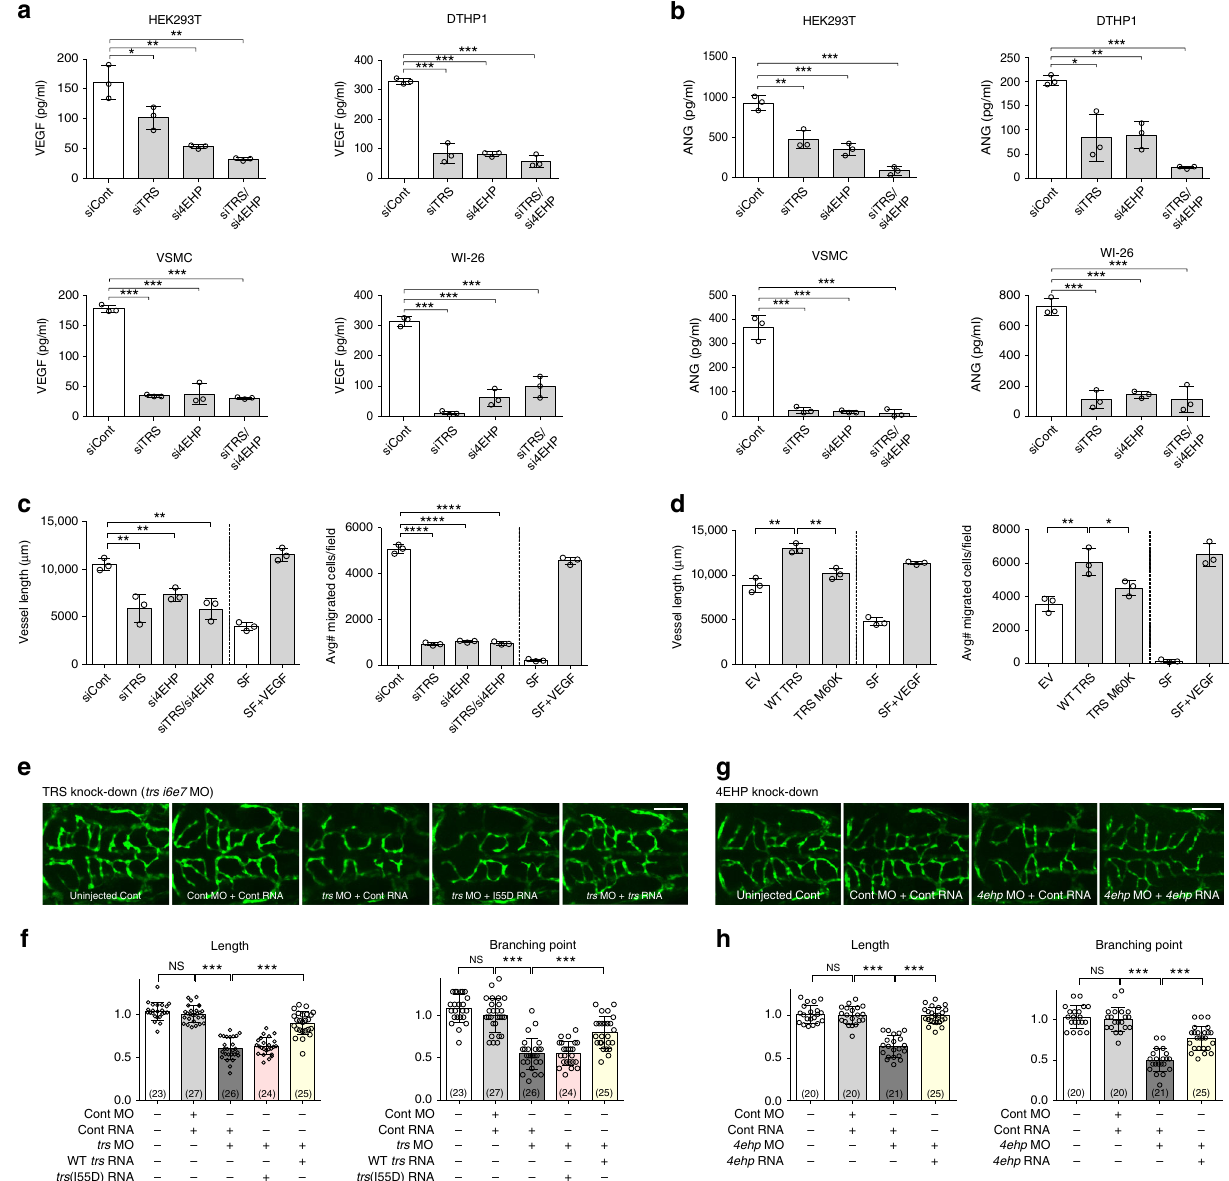
Fig. 5 The 4EHP and TRS interaction is critical for translation initiation of mRNAs required for vascular development. a Effects of TRS and/or 4EHP on VEGF secretion in siTRS- and/or si4EHP-transfected cell lines. VEGF protein levels in the culture supernatant were determined by enzyme-linked immunosorbent assay (ELISA). b Effects of TRS and/or 4EHP on ANG secretion in siTRS- and/or si4EHP-transfected cell lines. ANG protein levels in the culture supernatant were determined by ELISA. c , d Effects of TRS and/or 4EHP on endothelial cell tube formation. Culture medium from WI-26 cells transiently transfected with siRNAs against TRS and/or 4EHP (or siCont) was used to treat HUVECs, which were subsequently plated on growth factor- reduced Matrigel to form capillary tubes ( c ). Total tube lengths in Supplementary Fig. 6a were measured using ImageJ ( c ). Migrated HUVECs were counted from three randomly selected fi elds ( c ). Culture medium from WI-26 cells transiently transfected with Myc-TRS WT or its 4EHP-binding-defective M60K mutant was used to treat HUVECs, which were subsequently plated on growth factor-reduced Matrigel to form capillary tubes ( d ). Total tube lengths in Supplementary Fig. 6f were measured using ImageJ ( d ). Migrated HUVECs were counted from three randomly selected fi elds ( d ). VEGF (10 ng mL -1 ) served as a positive control. siCont, non-targeting control siRNA. * p < 0.05; ** p < 0.01; *** p < 0.001; **** p < 0.0001 vs. control group. Values are means ± SD of three independent experiments ( a − d ). e − h TRS- and 4EHP-mediated translation initiation is critical for vascular development. TRS was suppressed using a morpholino ( trs i6e7 MO) together with control (Cont) RNA, or reconstituted with WT or I55D mutant trs RNA at 52 h post-fertilization ( e ). 4EHP was suppressed using a morpholino ( 4ehp MO) together with Cont RNA, or reconstituted with WT 4ehp RNA ( g ). Quantitation and statistical analysis of the lengths and branching points of central arteries in the hindbrain of Tg ( kdrl:EGFP ) zebra fi sh embryos ( f , h ). Scale bar = 100 μ M. The number of analyzed zebra fi sh embryos is shown in parentheses. *** p < 0.001; NS not signi fi cant vs. control group. Values are means ± SD. SF serum-free